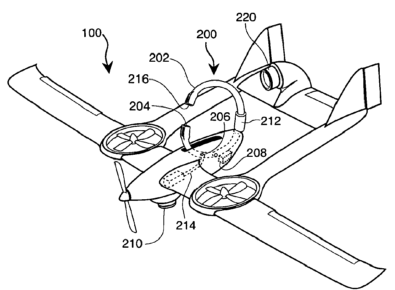
Figure 41. Charging from the power supply line [96]. 100 UAV; 202, magnetic core; 212, winding; 204, movable part of the magnetic core; 216, surface of the interfacing of parts of the core,